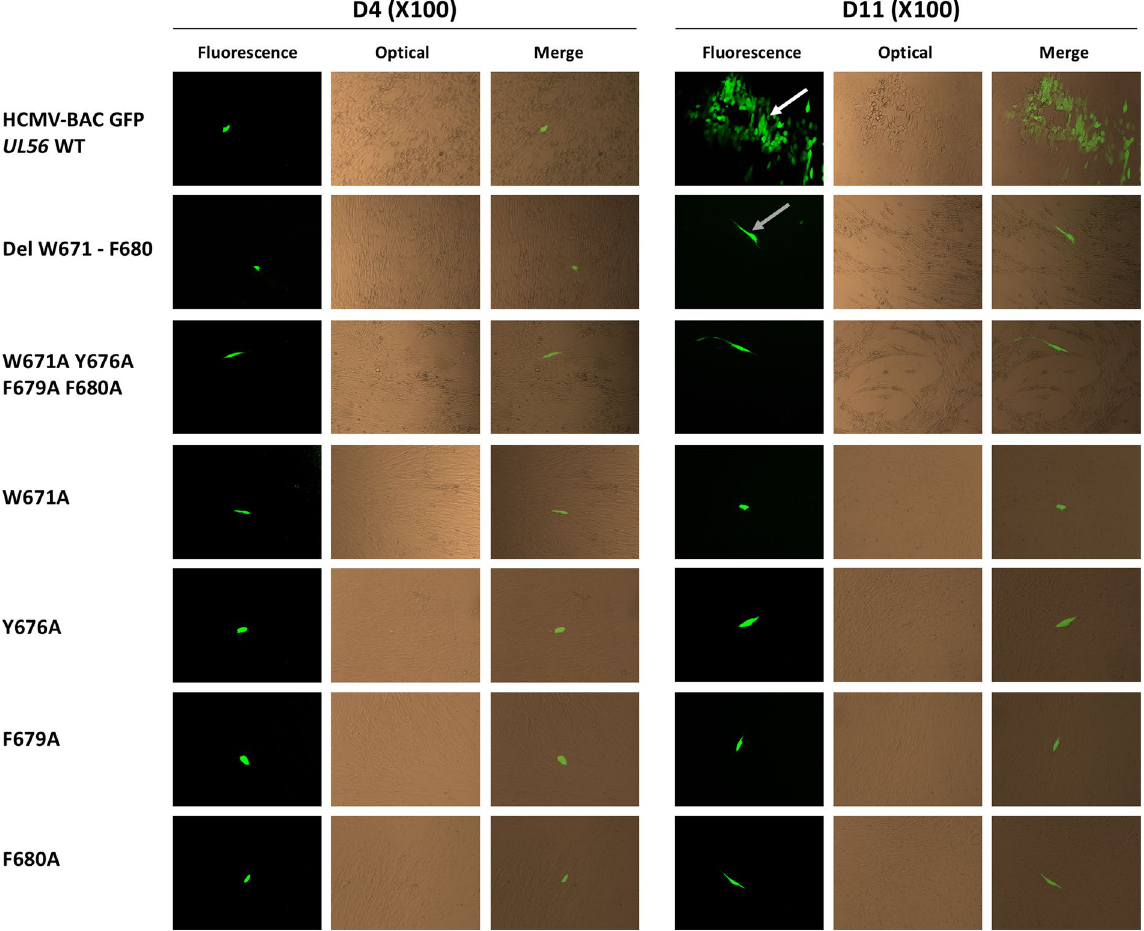
Figure 2. Plaque formation assay in MRC-5 cells after transfection of HCMV-BAC GFP UL56 WT (AD169) or recombinant virus strains with a deletion, a combination of mutations or a single mutation. Green fluorescent foci (white arrow) were observed with the wild-type HCMV-BAC GFP UL56 and single infected cells (grey arrow) were observed with the other recombinants viruses. Eleven days after transfection of human fibroblasts, we observed no cytopathic effect for either the mutant with a deletion of 671 WMVVKYMGFF 680 sequence, or a combination of mutations or single mutations. These mutations dramatically impaired viral replication and propagation in